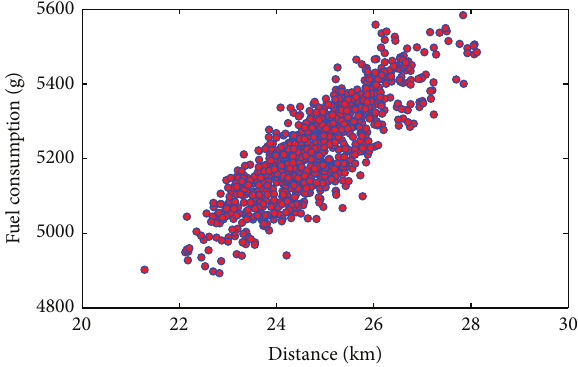
Figure 7: Relationship between distance and fuel